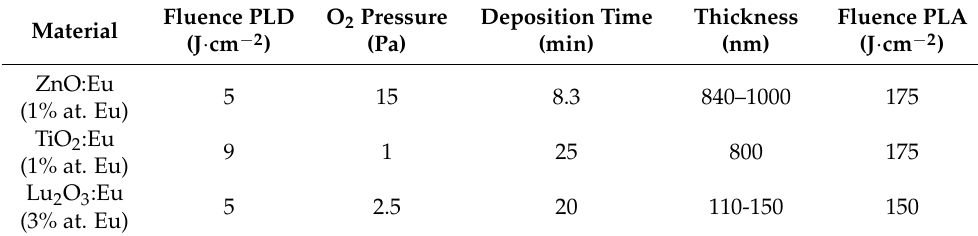
Table 1. The deposition and laser annealing